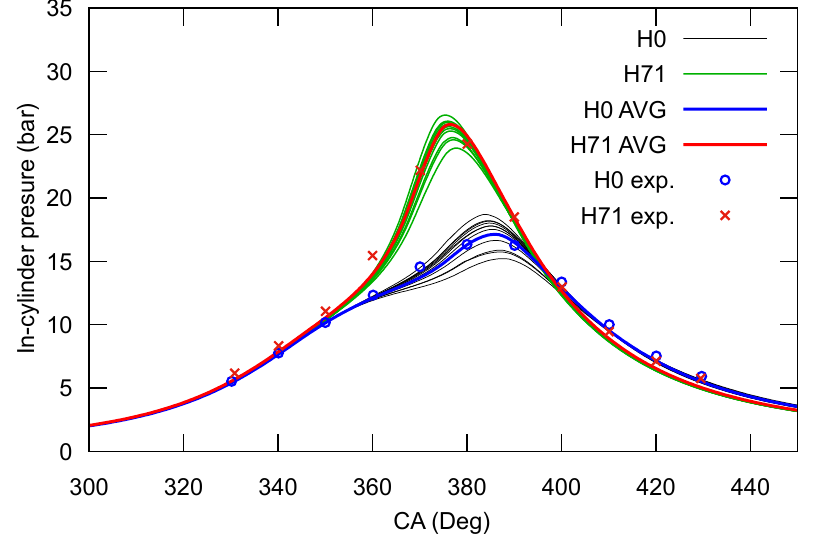
Figure 2. Plot of several cycles of in-cylinder pressure during combustion against crank angle (CA). Two hydrogen concentrations are shown, H0 and H71, for a fuel–air ratio φ = 0.79. Thin lines represent individual simulated cycles; thick lines, average values (denoted as AVG); and symbols, experimental data